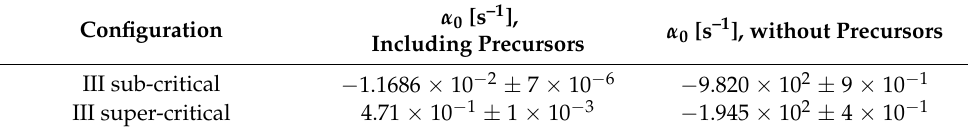
Table 7. Fundamental eigenvalues α 0 for Problem